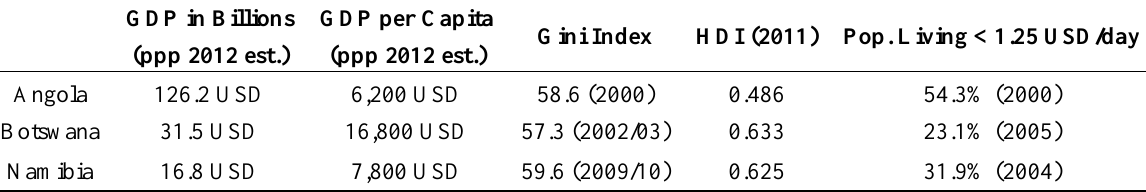
Table 2. Economy and development in Angola, Botswana and Namibia